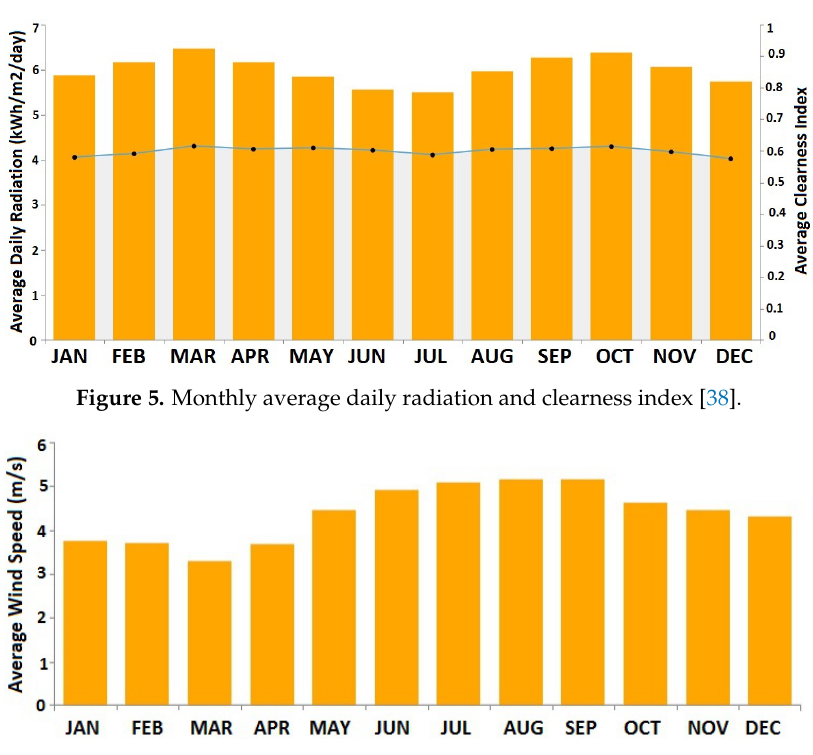
Figure 6. Monthly average wind speed [38].